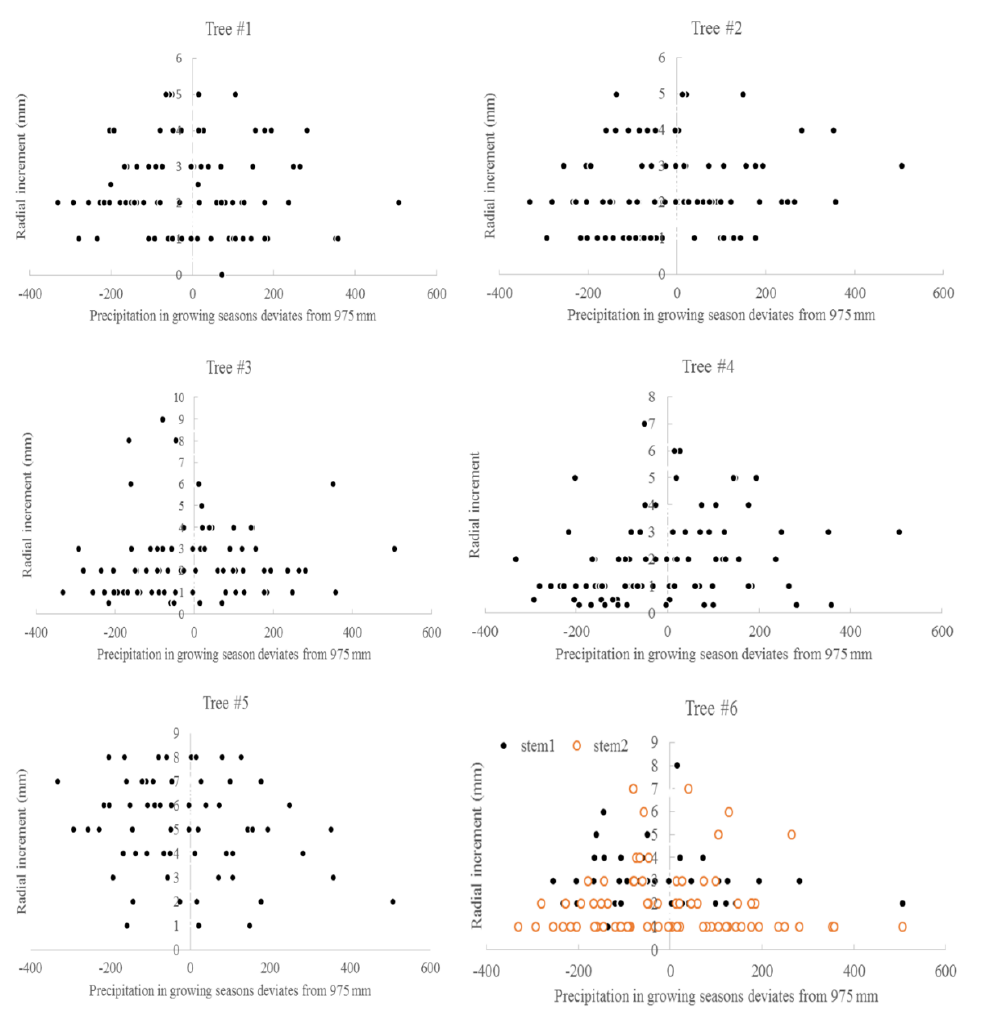
Figure 6. Precipitation in growing seasons and annual radial increments for six Chinese Torreya trees.